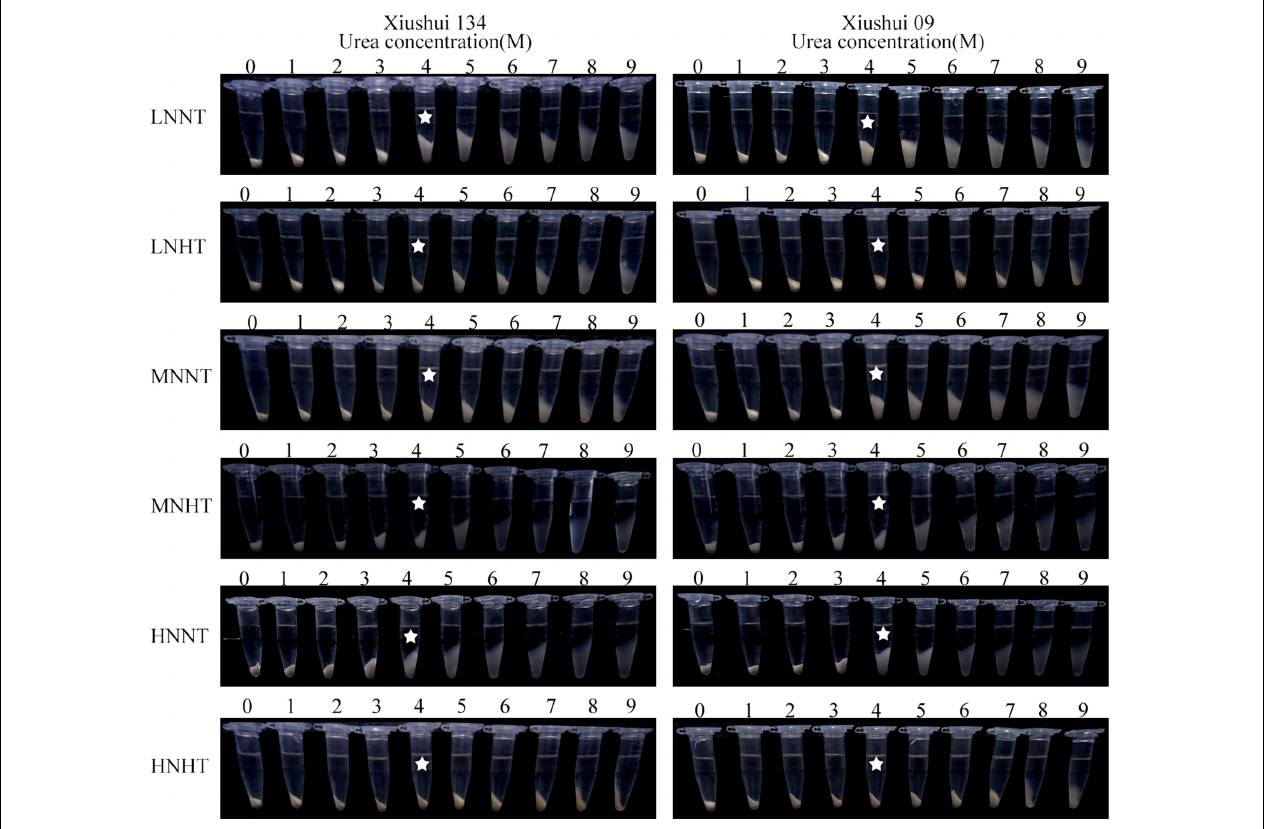
FIGURE 3 | Effects of the urea concentrations on SP of starch granules for different nitrogen-temperature treatments. LN-NT, MN-NT, HN-NT, LN-HT, MN-NT, and HN-HT indicate low nitrogen-normal temperature, moderate nitrogen-normal temperature, high nitrogen-normal temperature, low nitrogen-high temperature, moderate nitrogen-high temperature, and high nitrogen-high temperature, respectively.